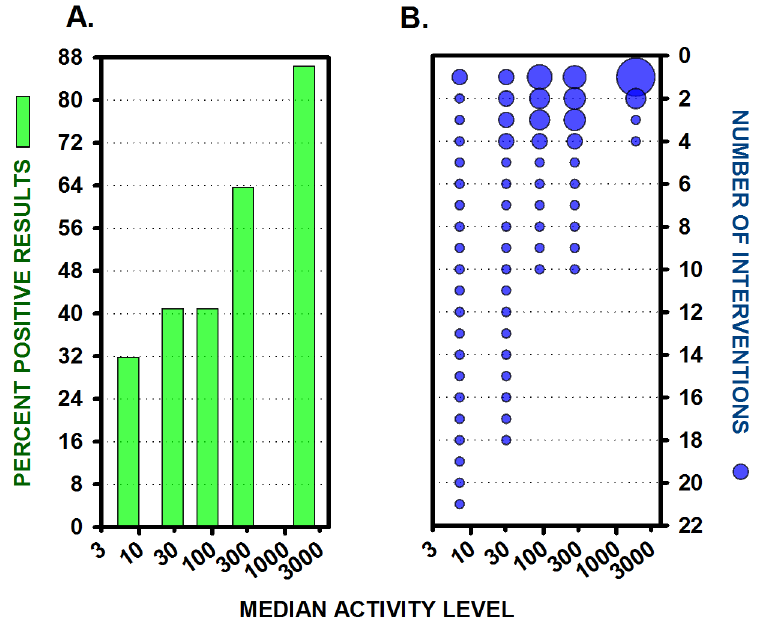
Fig 5. Success rates increase and number of topics decrease as research activity levels increase. (A) Percent successful, or positive, statistically significant results, at median activity levels for 5 equal groups (n’s = 22). (B) The number of interventions or topics of research is shown at each activity level. Symbol size indicates the number of studies being conducted on the same topic. The Y axes is inverted in this panel in order to convey the concept that, over time, only a small number of reliable findings rise to the